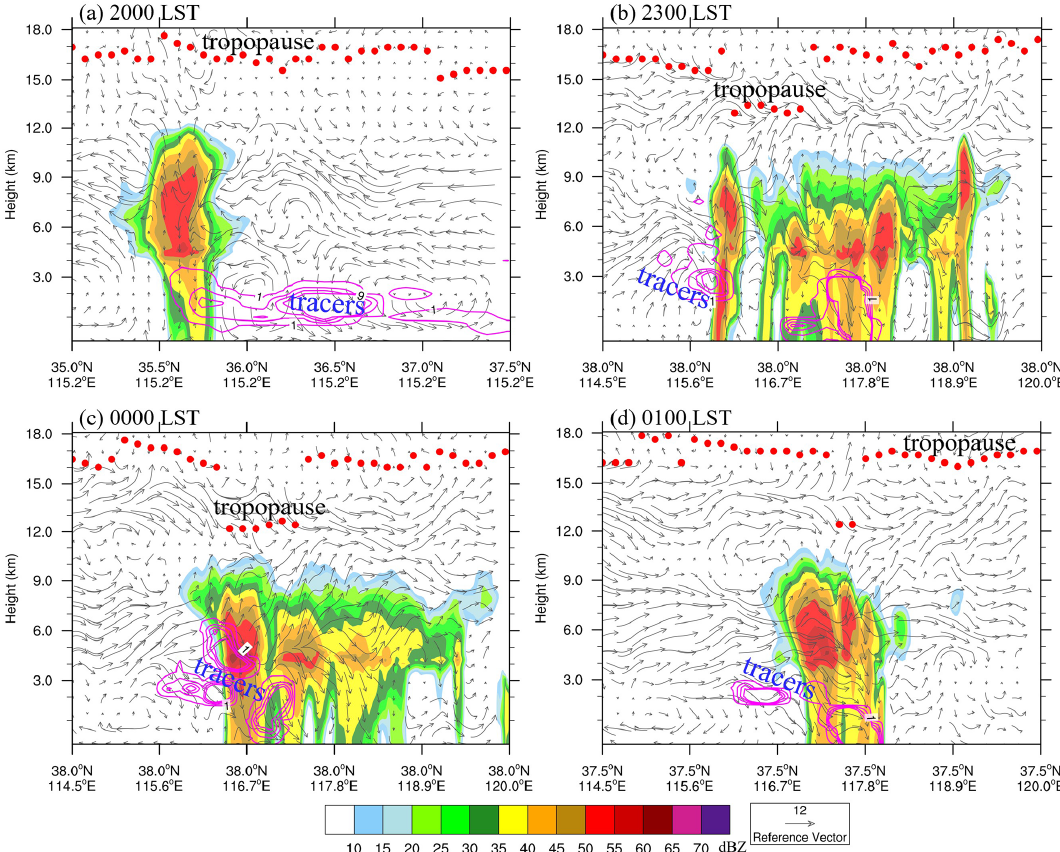
Figure 11. Cross sections of WRF-simulated radar reflectivity structure (shaded; dBZ), tracer particle counts from the FLEXPART model (magenta lines, the value of the outmost contour line is 1 and the contour interval is 2) and wind flows (vectors) at (a) 20:00 LST and (b) 23:00 LST on 31 July, and at (c) 00:00 LST and 01:00 LST on 1 August 2021. The red circles represent the thermal tropopause height calculated from WRF simulations. The cross-section lines are shown in Fig.